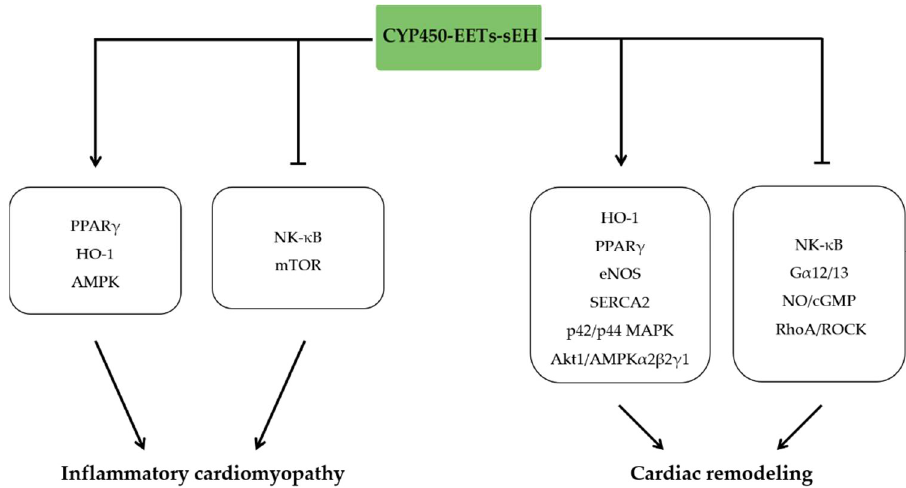
Figure 2. The anti-inflammatory effects of EETs in heart disease. EETs protect against inflammatory cardiomyopathy by activating PPARγ, HO-1, and AMPK signaling pathways and inhibiting NF-κB and mTOR signaling pathways. EETs also attenuate cardiac remodeling by enhancing HO-1, PPARγ, SERCA2, and MAPK and inhibiting NF-κB, Gα12/13 signaling pathways.